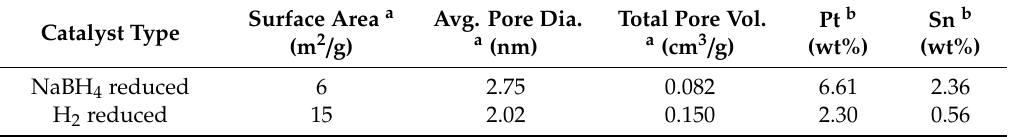
Table 1. Properties of NaBH 4 and hydrogen reduced catalysts.